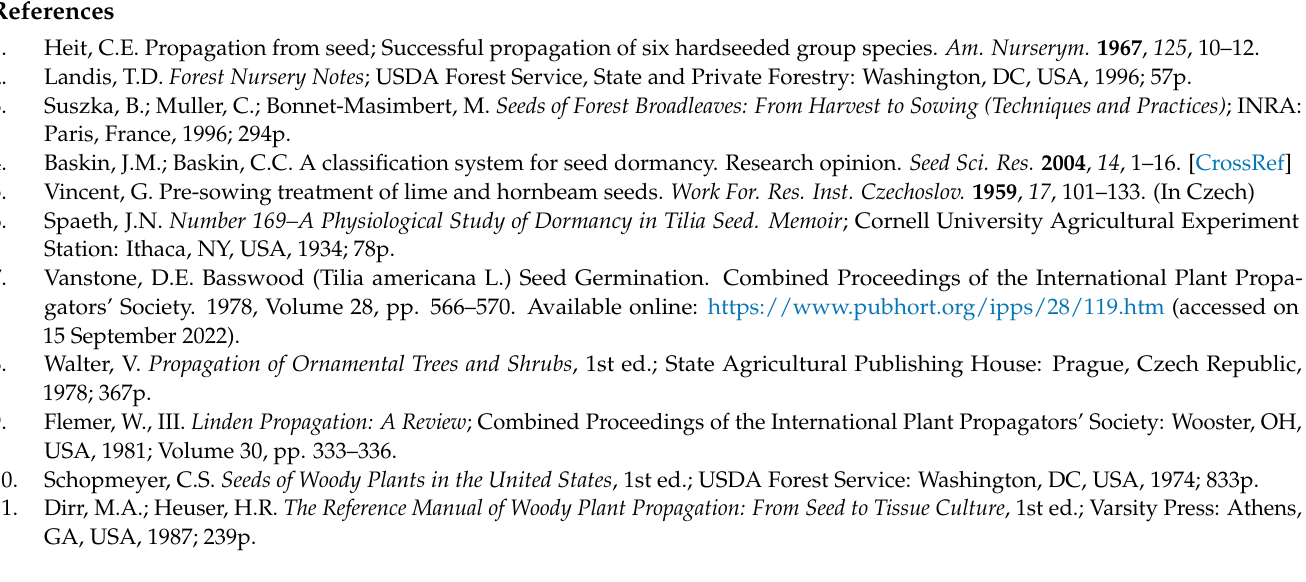
Warm-cold stratification of seed Duration of the Duration of warm phase